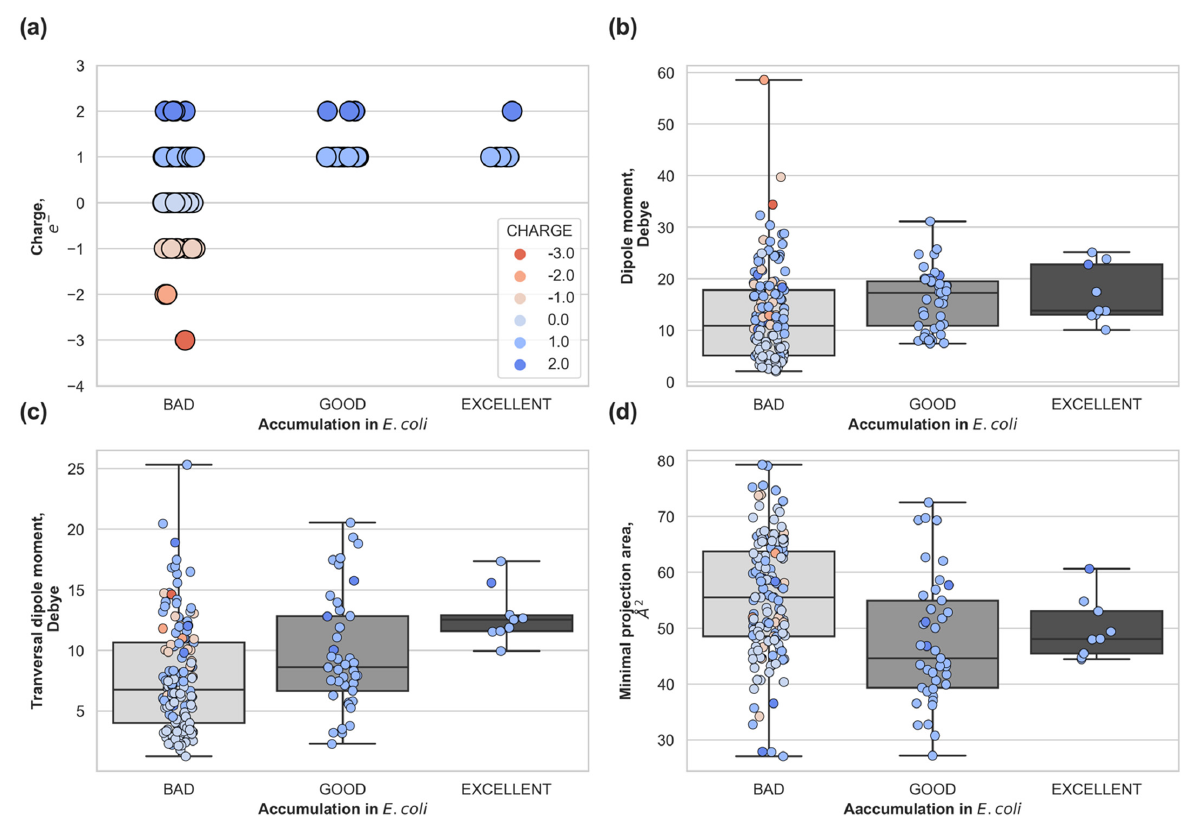
Figure 2. Whole-cell accumulation in E. coli versus molecular descriptors for the compounds with non-negligible accumu- lation: ( a ) total charge of the compound, ( b ) total dipole moment, ( c ) transversal dipole moment and ( d ) minimal projection area. Compounds are grouped as: Low Accumulators (<250 nmol per 10 12 CFUs), Accumulators (<550 nmol per 10 12 CFUs), Good Accumulators (>550 nmol per 10 12 CFUs), and Excellent Accumulators (>1000 nmol per 10 12 CFUs).